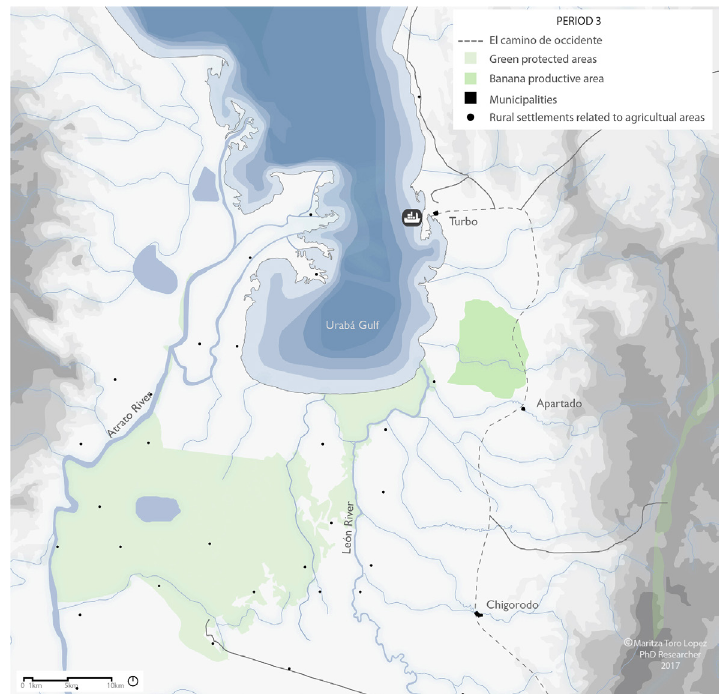
Fig. 4 . Period 3: The natural and artificial infrastructures of the region resulted in the establishment of important precedents for the future. Source: own